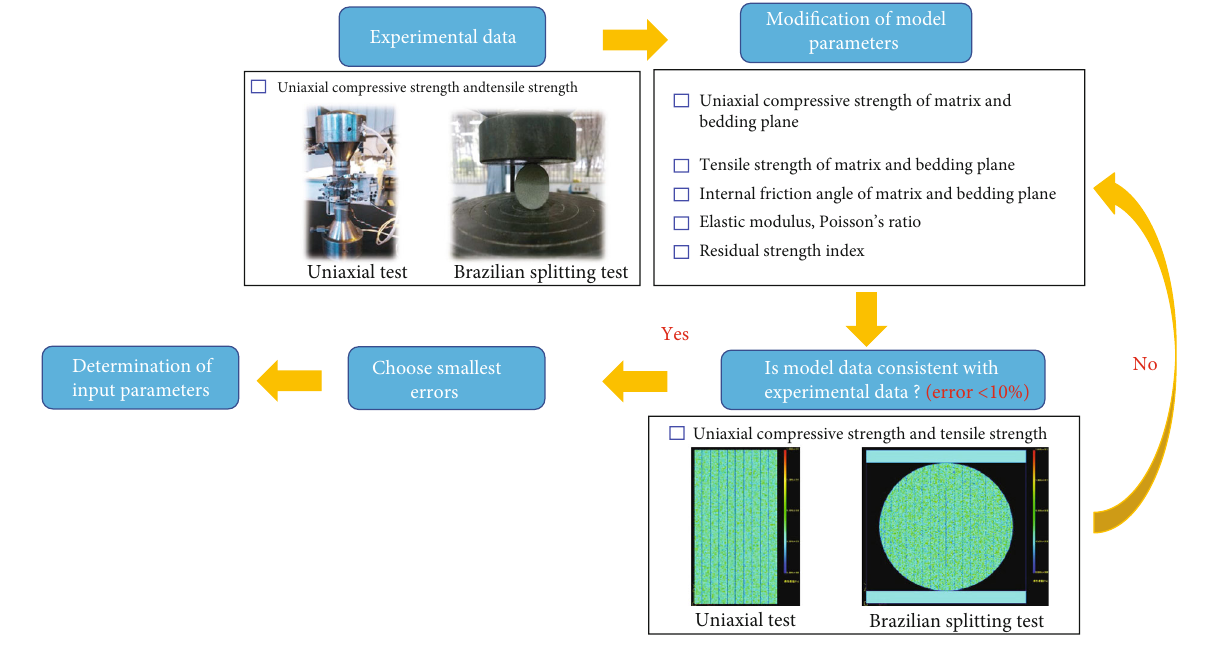
Figure 5: Schematic of determining mechanical parameters of model.